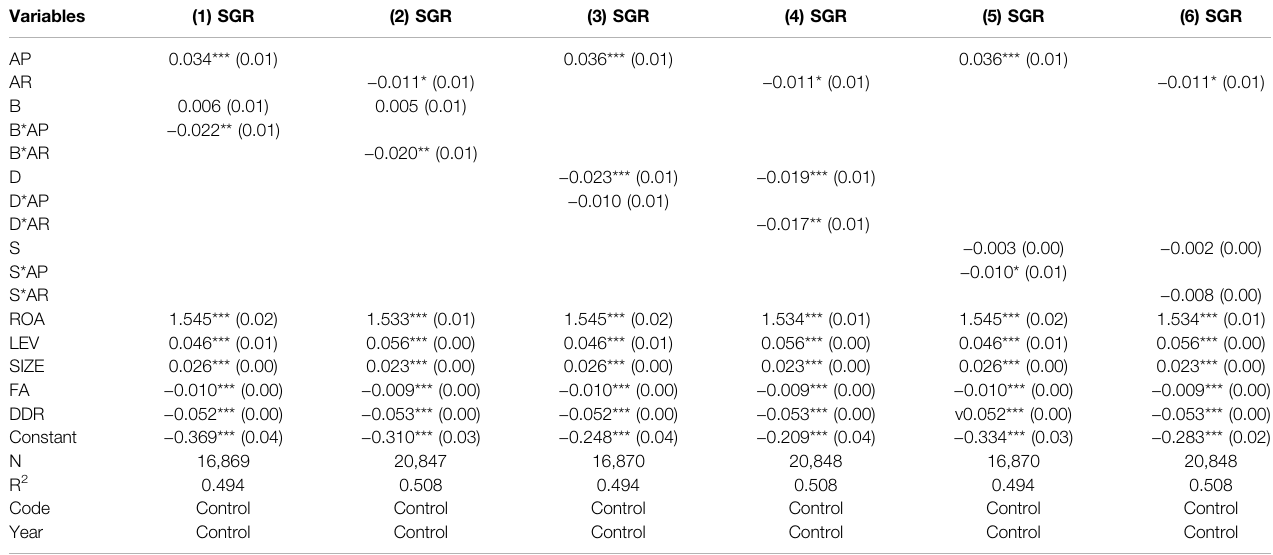
TABLE 13 | The structural impact of digital fi nance.